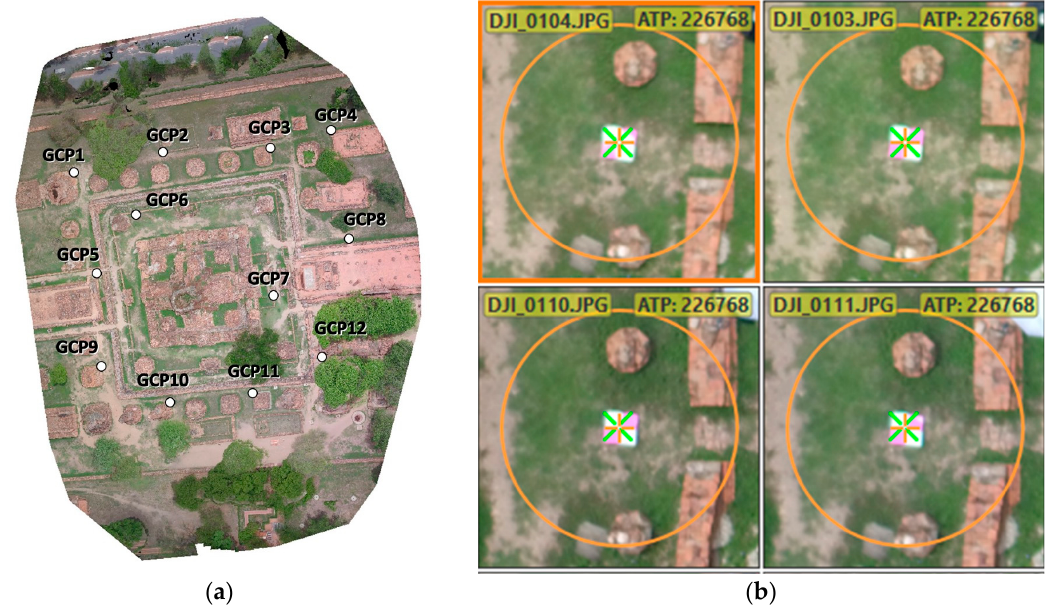
Figure 6. GCPs measured with a real-time kinematic global navigation satellite system (GNSS). ( a ) The locations of 12 GCPs. ( b ) GCPs marking.